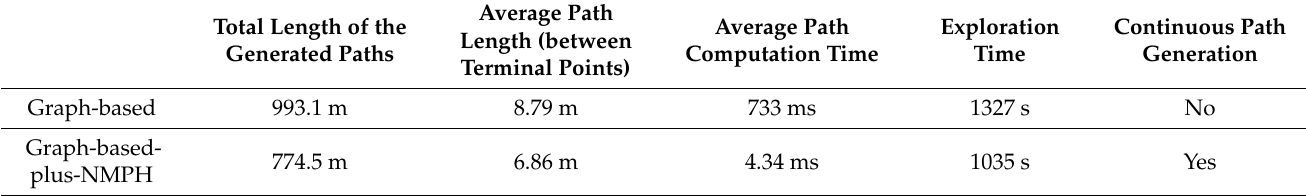
Table 1. Comparison between Graph-based and Graph-based-plus-NMPH approaches to path planning.